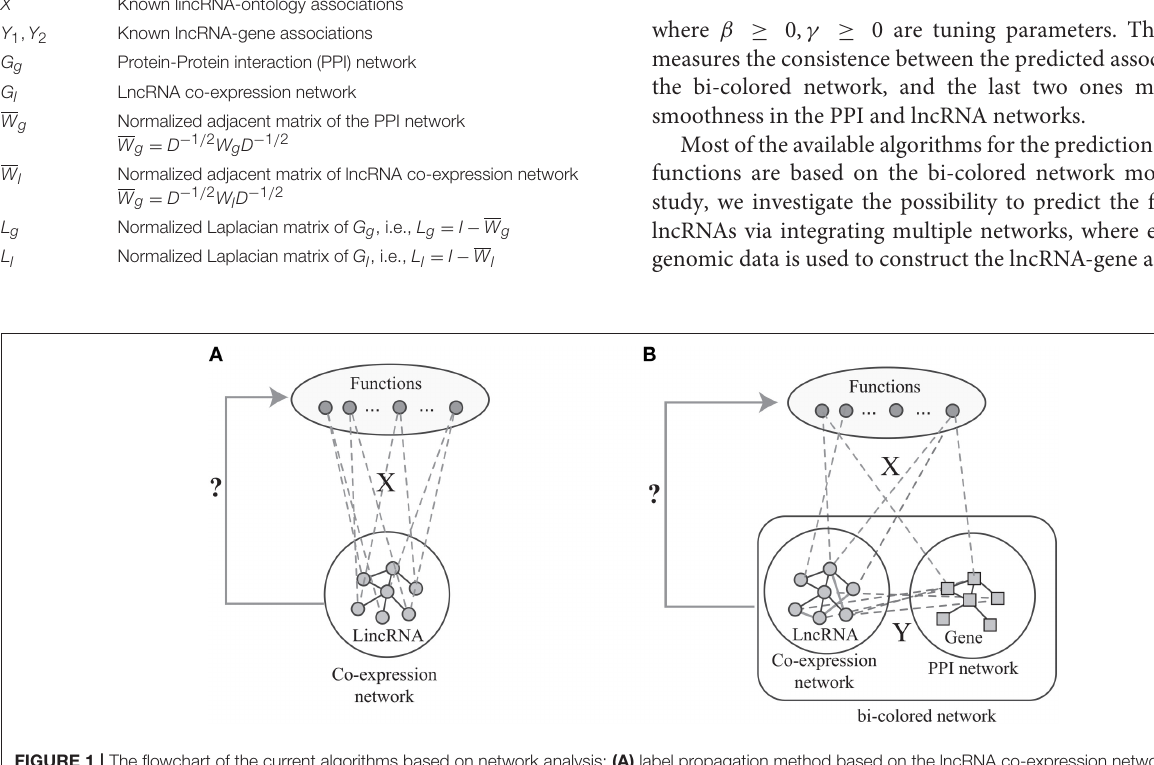
Frontiers in Genetics |